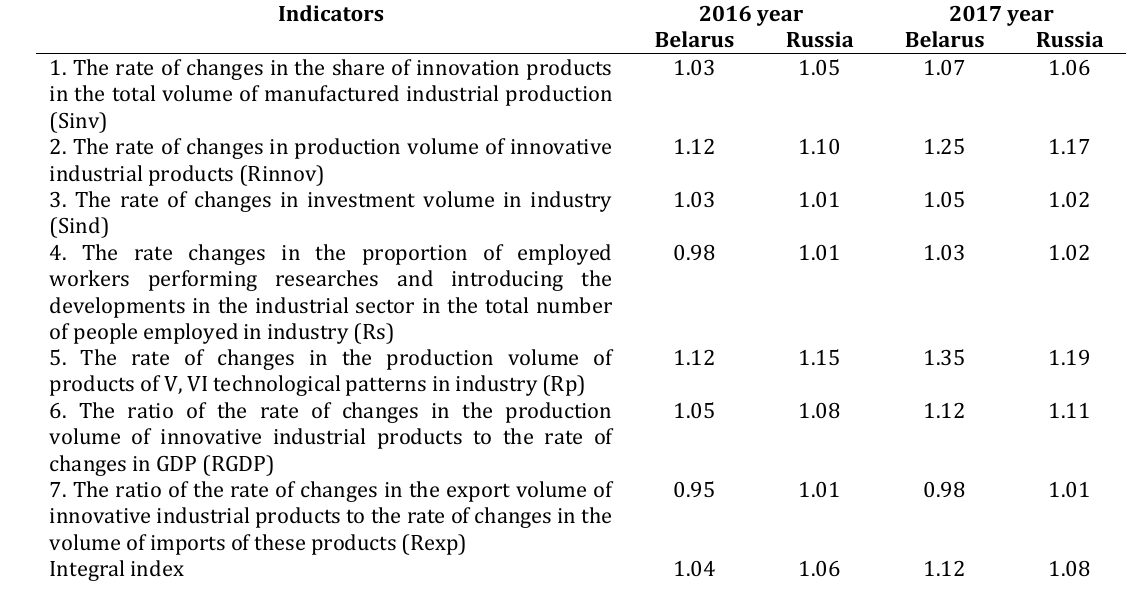
Table 1: The results of calculations of the effectiveness evaluation of neo-industrialization of countries